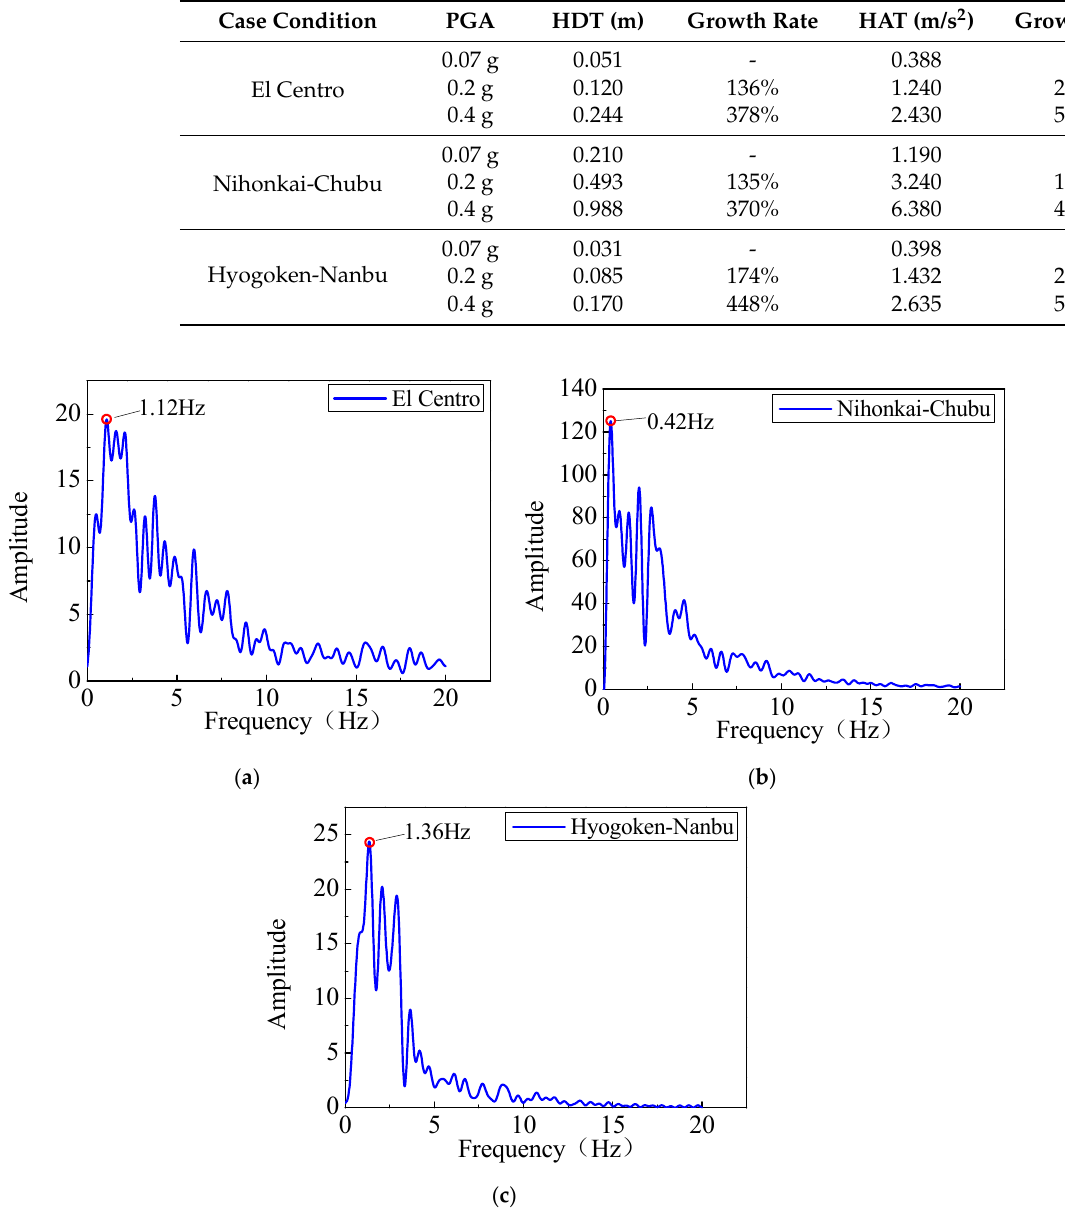
Table 5. Dynamic response of structures under different seismic records.